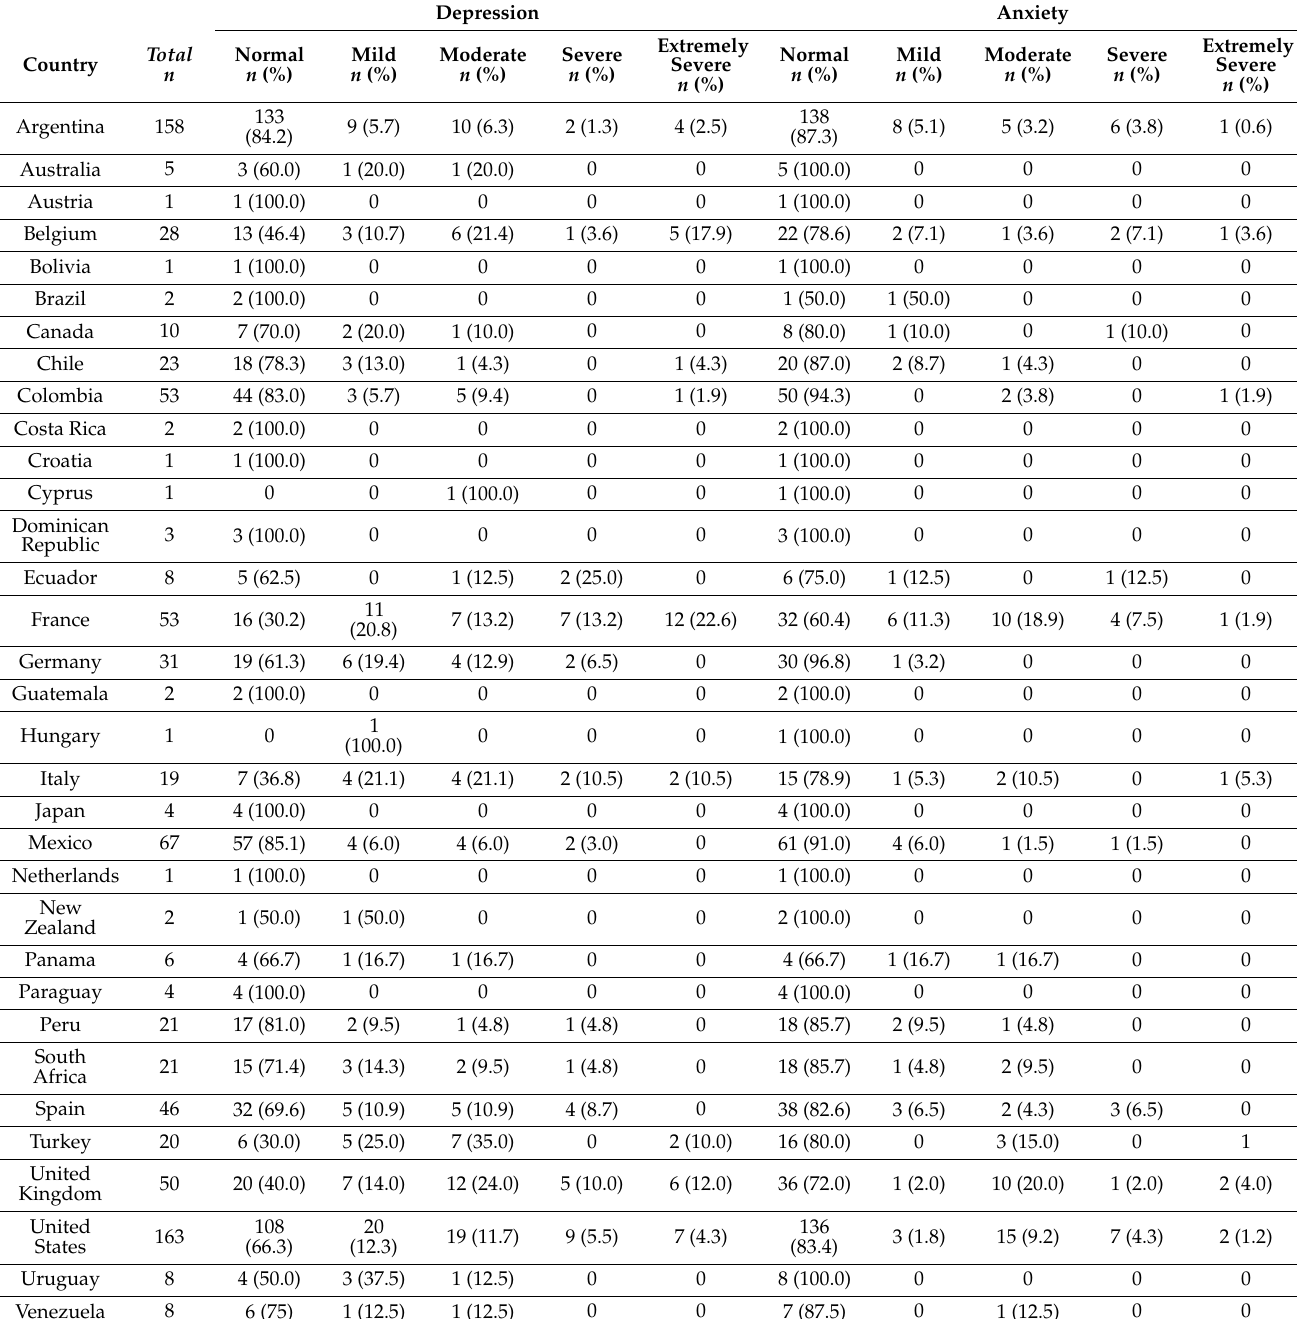
Table 4. Depression and Anxiety Distribution by